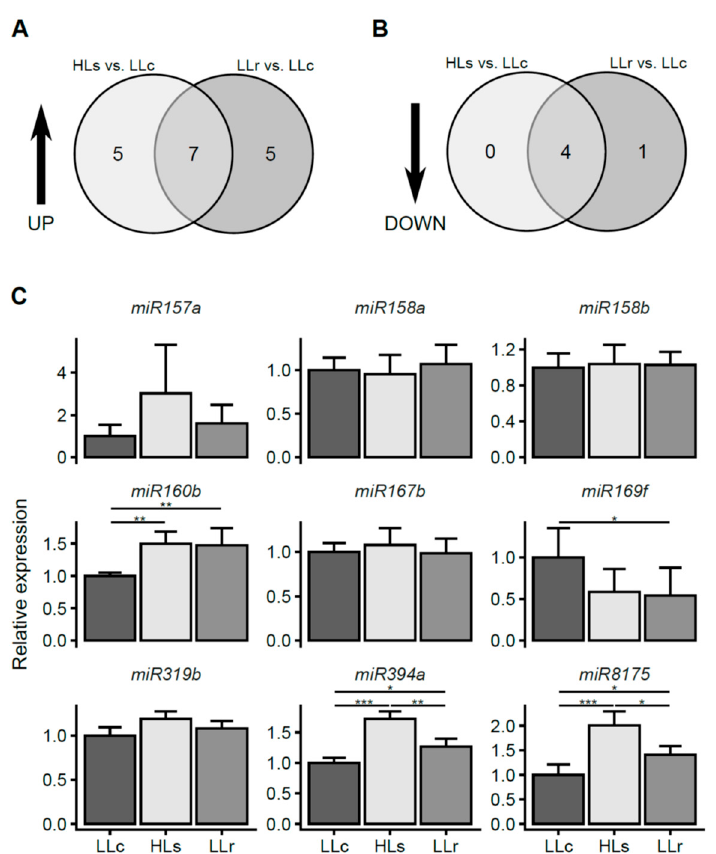
Figure 2. Micro-transcriptomic changes in A. thaliana roots induced by HL treatment of rosettes ( A ) Venn diagram representing the number of miRNAs that were up-regulated after HL treatment compared to control roots. ( B ) Venn diagram representing the number of miRNAs that were down-regulated after HL treatment compared to control roots. ( C ) Validation of selected micro-transcriptomic changes in miRNA expression, relative to the expression of two references, snoRNA85 and snoRNA101 , using the RT-qPCR method. Error bars represent the standard deviation, and asterisks represent significant differences at p -values <0.05 (*), <0.01 (**), and <0.001 (***). ANOVA and the HSD Tukey test were applied for statistical analysis. Results are from three independent experiments each pooled from six plants and three technical